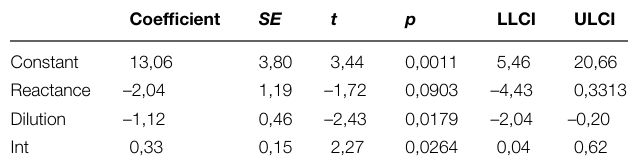
TABLE 4 | Interaction